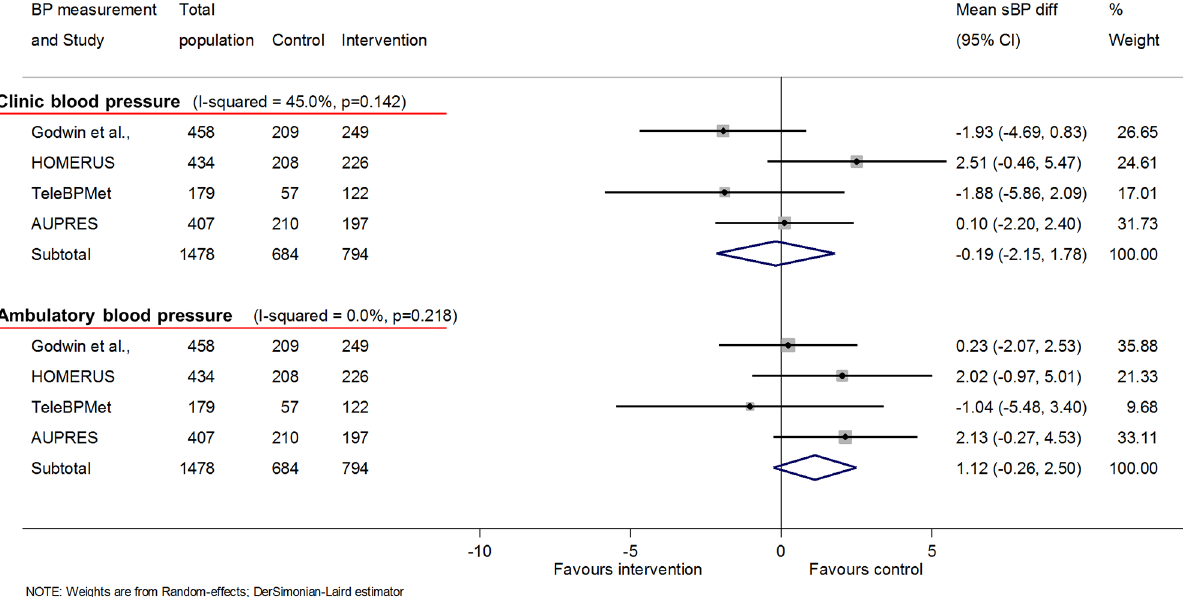
Fig 4. Impact of self-monitoring of BP on clinic and ambulatory sBP at 12 months (4 studies). These 4 studies used both clinic and ambulatoryBP as endpointsand so are presentedin addition to the overall results in Fig 1, which are for clinic BP alone (includingthese studies). Changein sBP adjustedfor age, sex, baselineclinic BP, history of diabetes,and level of intervention. Effect of self-monitoring on systolic clinic and ambulatory BP at 6 months is in S9 Fig. Abbreviations: BP, blood pressure; sBP, systolic blood pressure.